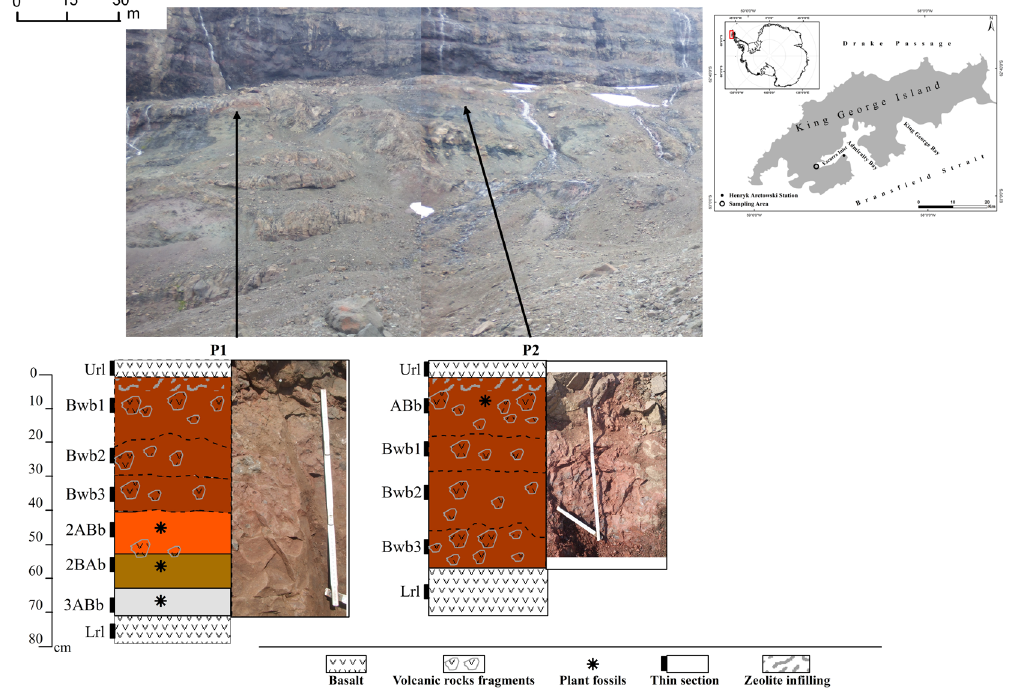
Figure 1. Overview of the sampling site at King George Island, location of the paleosols at the Cytadela outcrop and their schematic profile description (modified from Spinola et al . 27